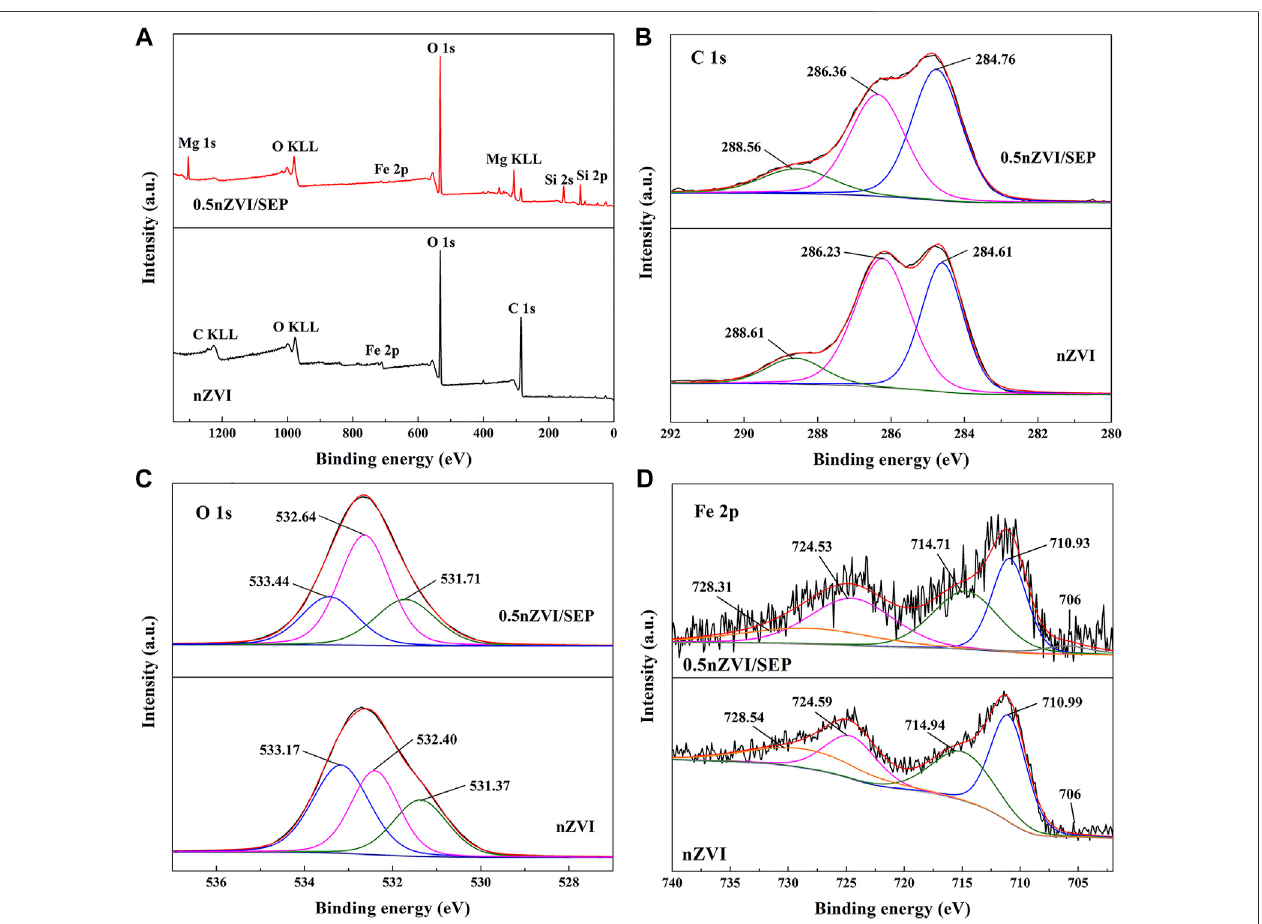
Frontiers in Chemistry |